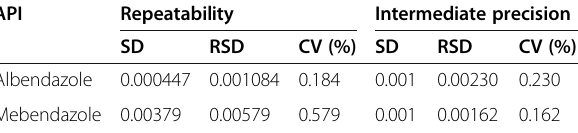
Table 1 Repeatability and intermediate